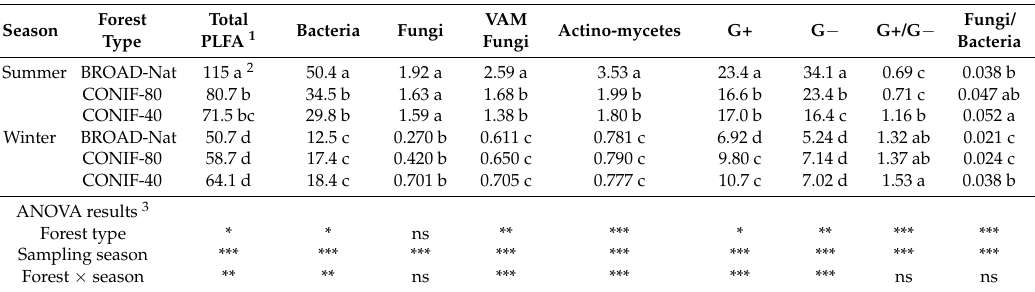
based on Duncan’s multiple test; * p < 0.05, ** p < 0.01, *** p < 0.001, ns: not significant. Table 4. Contents of phospholipid acid biomarkers (nmol ∙ g − 1 soil) and biomarker content ratios in 40 ‐ broadleaf forest (BROAD ‐ Nat) in two seasons.